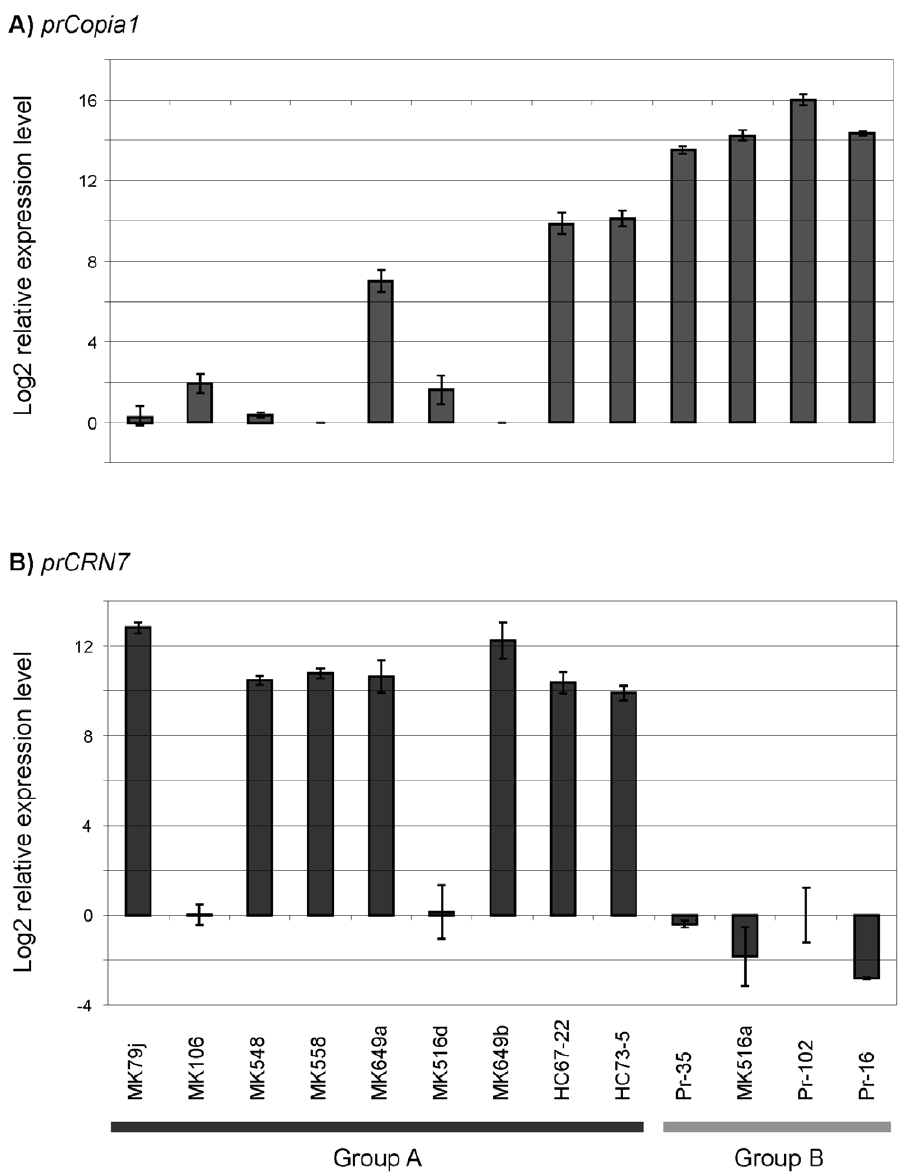
Figure 4. Validation of microarray data by qRT-PCR. qRT-PCR log2 fold changes ( 2 DD CT) are shown for two markers A) prCopia1 and B) prCRN7 . PR_76099 was used as endogenous control gene and expression levels were standardized to the genome sequence strain Pr-102. For prCopia1 , because the standard Pr-102 had the highest expression level, its expression was offset by 16 for presentation purpose.